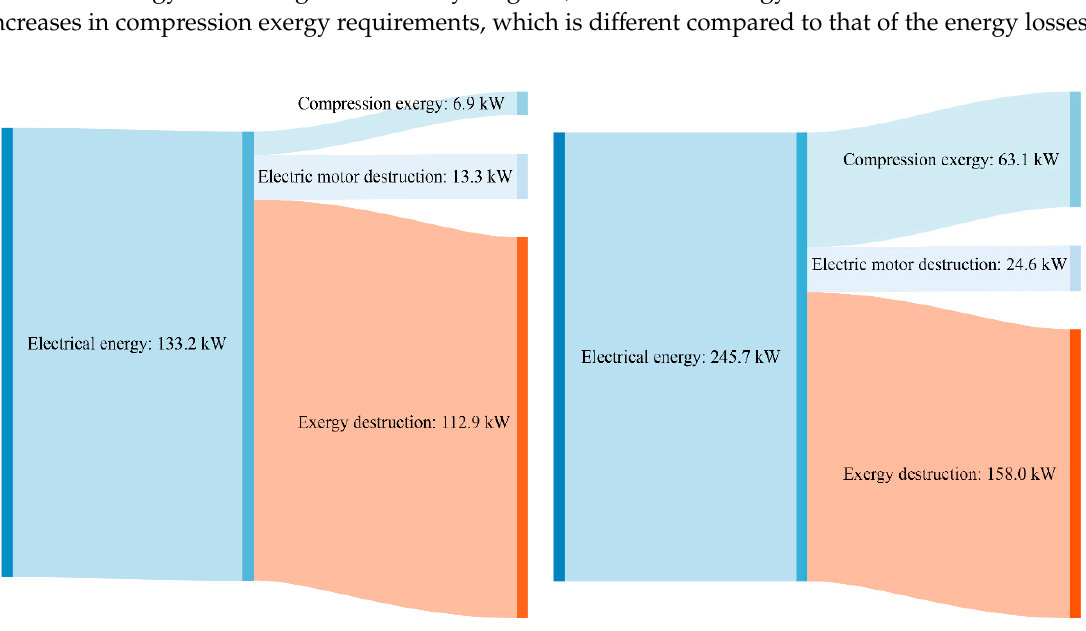
Figure 8. Sankey exergy flow diagram for the lowest and highest measured turbo compressor loads.